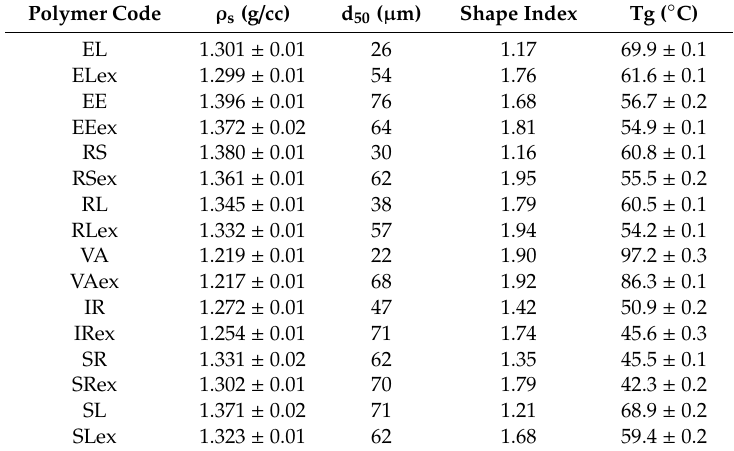
Table 2. Particledensity,size,shape,andglasstransitiontemperatureoftheexperimentalpolymericpowders. Polymer